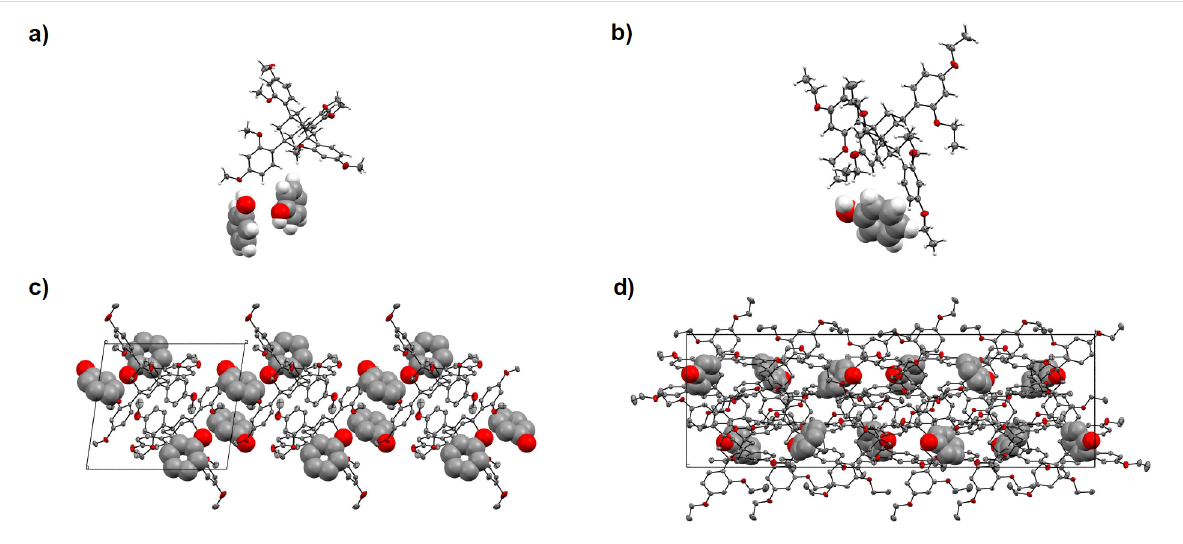
Figure 2: Details of the X-ray crystal structures obtained, shown as ORTEP plots at 50% probability, with van der Waals radii of the phenol molecules set to 60%. a) Asymmetric unit of the TDA/phenol co-crystal (space group P -1). b) Portion of the asymmetric unit of the TEO/phenol co-crystal (space group Cc ). c) Crystal packing in the TDA/phenol system, and d) crystal packing in the TEO/phenol